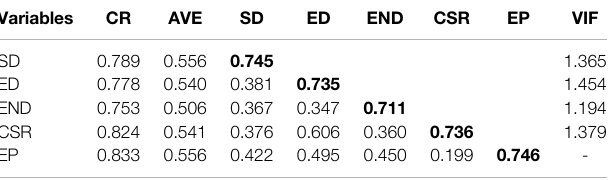
TABLE 4 | Discriminant validity, composite reliability and AVE. Variables